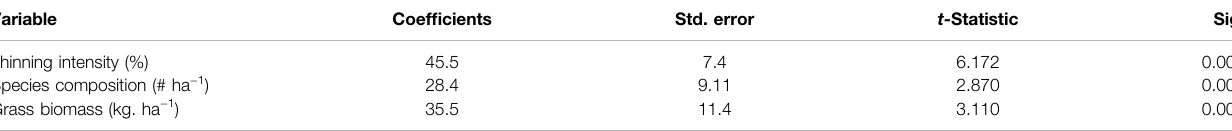
a Indicates signi fi cant positive correlation values between variables.